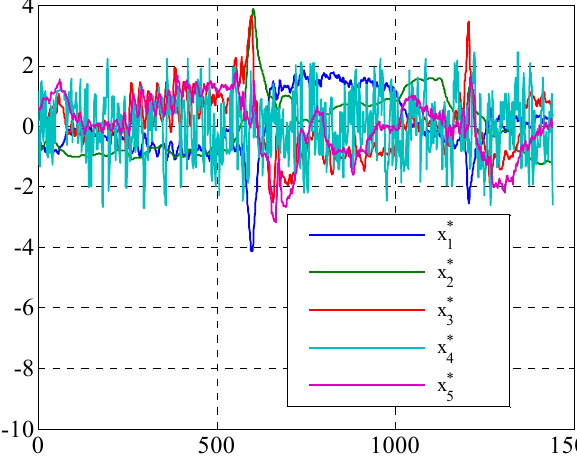
Figure 25. The standardized variable x ∗